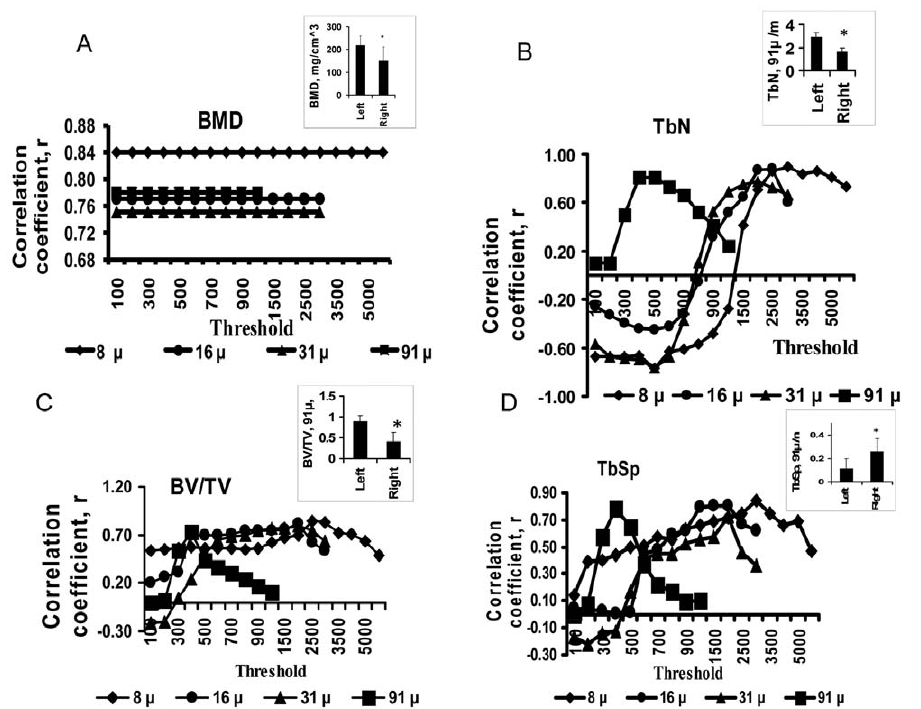
Figure 6. Assessment of trabecular morphologic parameters is threshold dependent; and, trabecular parameters are altered by prostate cancer involving bone. Variations in correlation coefficient (r) for metaphyseal bone mineral density (BMD, A), trabecular number (TbN, B) bone volume density (BV/TV, C), and trabecular separation (TbSp, D) by m CT at different thresholds and bone histomorphometry. Insets: using optimal thresholds, in vivo m CT at 91- m m voxel size shows significant differences in metaphyseal BMD (BMD, A), TbN (TbN, B), BV/TV (BV/TV, C) and TbSp (TbSp, D) between left and right femora 10 weeks after tumor inoculation.